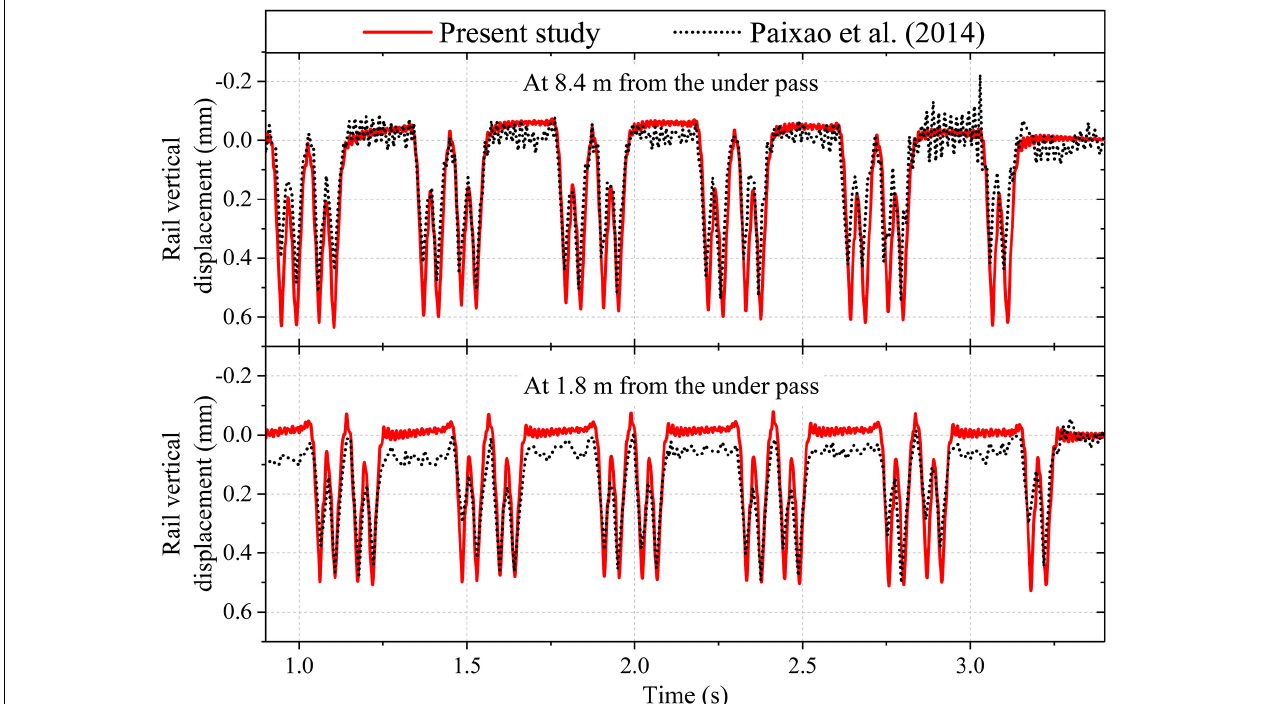
FIGURE 3 | Comparison of model predictions with the data reported by Paixão et al. (2014).